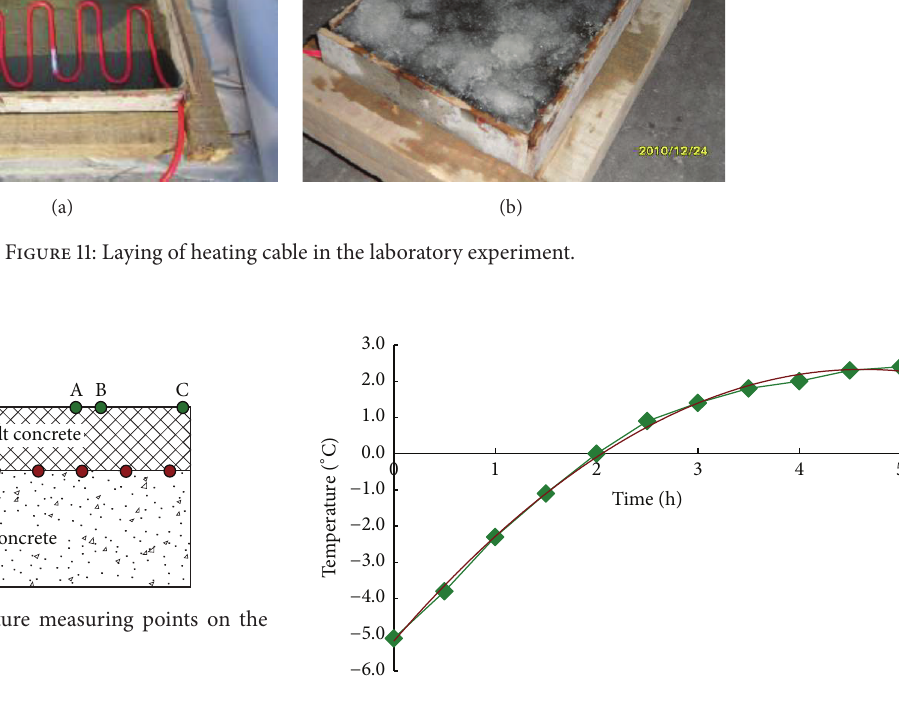
Figure 13: Temperature curve of the specimen surface with air temperature of − 5 ∘